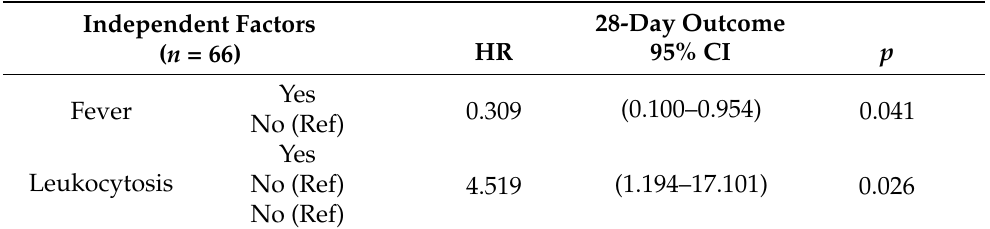
Table 8. Multiple logistic regression with backward method (Wald) of 28-day outcome and indepen- dent factors.